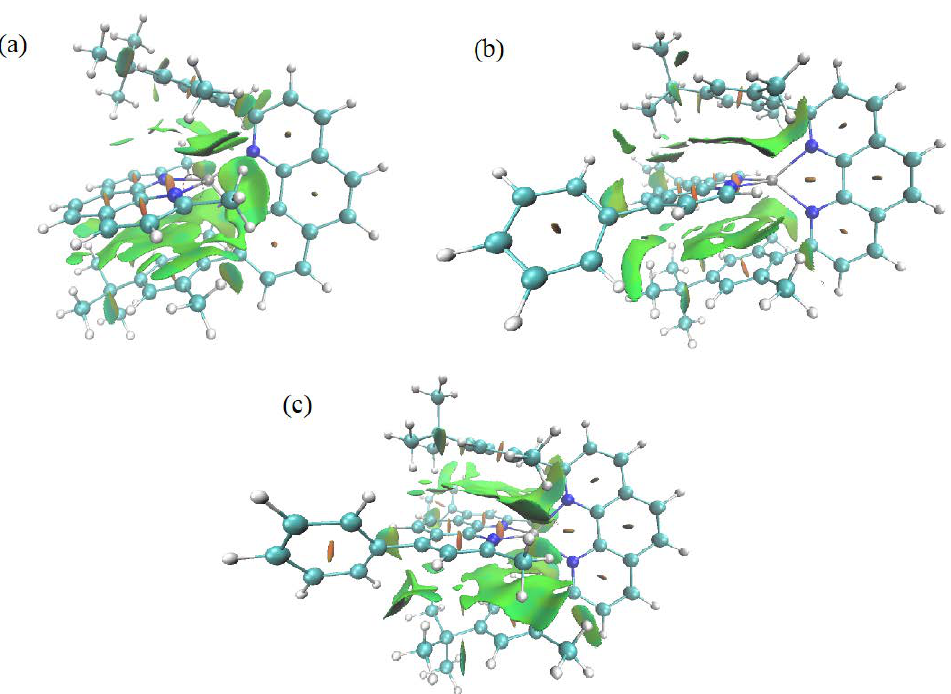
Figure 5. Non-covalent interactions present: ( a ) C2 , ( b ) C3 and ( c ) C4 .